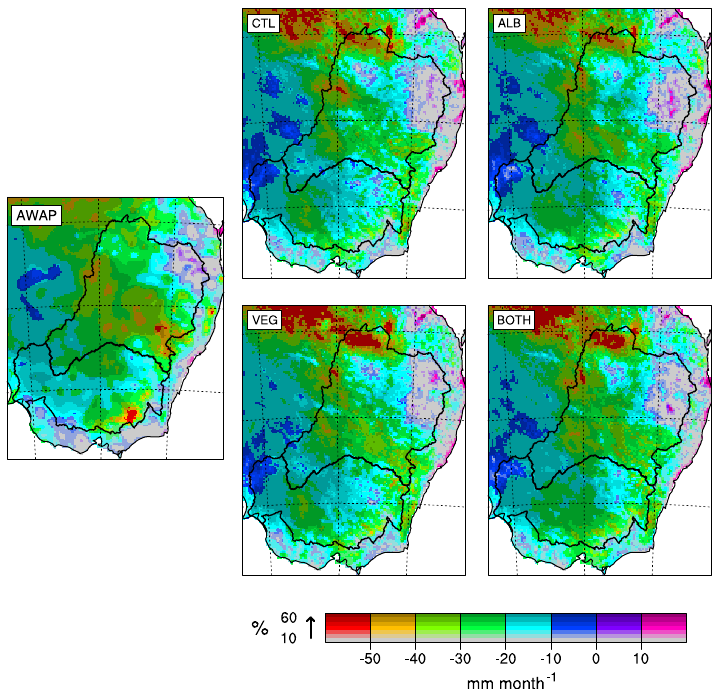
Figure 7. The precipitation change from 2000 (normal/wet) to 2002 (drought) for each model simulation and observations. The hue of the colours gives the change in mmmonth − 1 , while the saturation/intensity gives the change in percentage terms. Grey areas have less than 10% change.